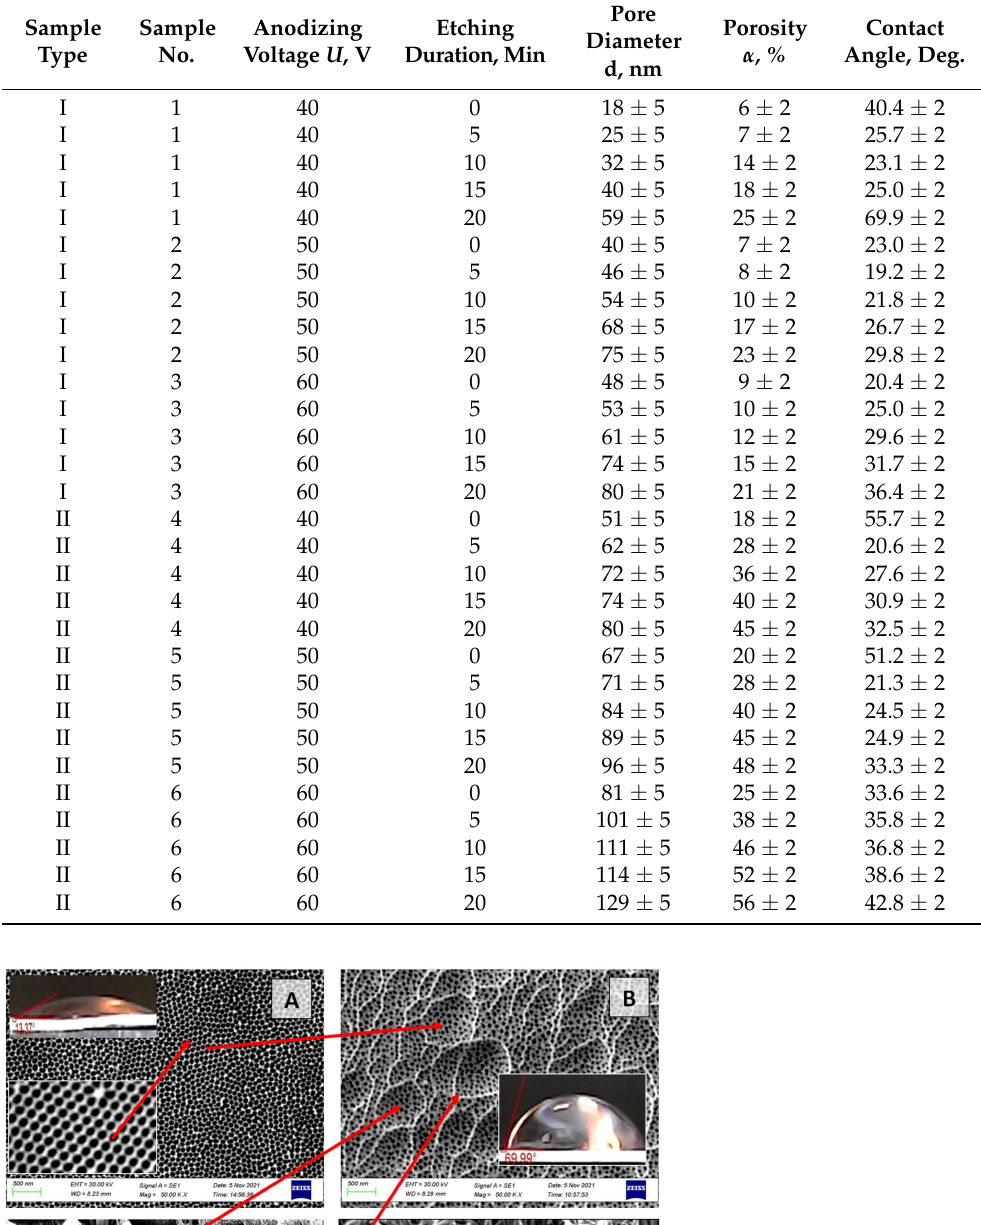
Table 2. The main conditions for PAA preparation of the experimental samples (as-fabricated and after chemical modification) and the main parameters of both types of samples.